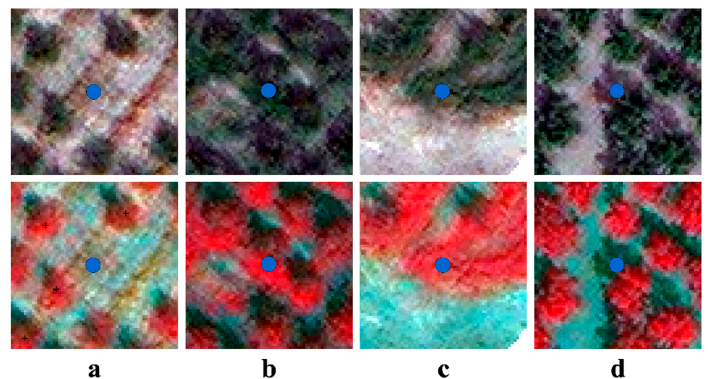
Figure 6. Example of ( a ) type “A” error; ( b ) type “B” error; ( c ) type “C” error; ( d ) type “D” error (top: crowdsourced observation overlaid on true color composite; bottom: crowdsourced observation overlaid on NIR1, R, and G false color composite; blue circle and the black cross symbols show the location of misidentified and correctly identified trees in the crowdsourced dataset, respectively).